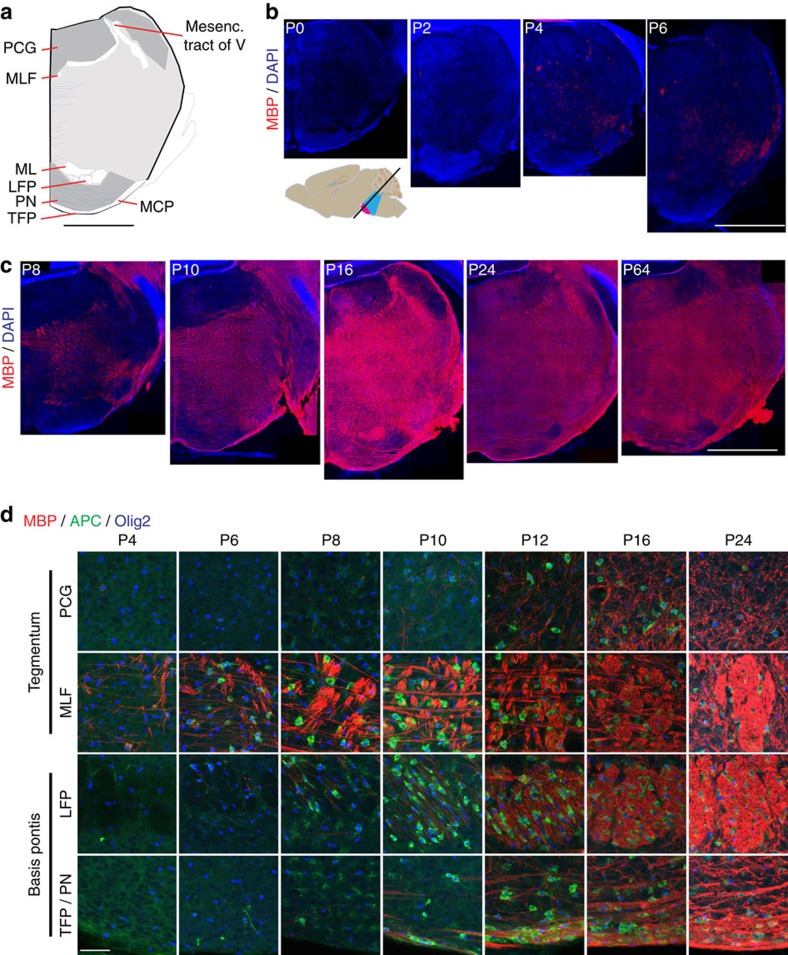
Progressive myelination in pons.(a) P16 pons section stained for myelin basic protein (MBP) was traced to highlight landmark tracts and grey/white regions. Lines indicate thick fibres within grey matter regions. (b,c) MBP-stained pons hemisections at indicated ages; red, MBP; blue, DAPI. Scale bar for (a–c)=1 mm. (d) High-resolution images of representative pons regions, including both grey and white matter within tegmentum and basis, illustrate differently timed regional onsets of myelination and progressive increase over postnatal development. Red, MBP; green, APC; blue, Olig2. Scale bar, 50 μm. LFP, longitudinal fasciculus pontis; MCP, middle cerebellar peduncle; ML, medial lemniscus; MLF, medial longitudinal fasciculus; PCG, pontine central grey; PN, pontine nuclei; TFP, transverse fasciculus pontis.